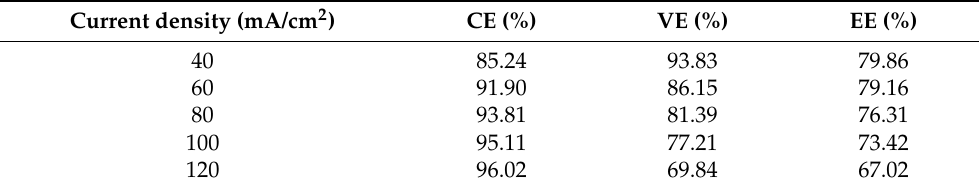
Figure 9. Efficiencies of the VRFB single cell with APPJ-coated polydopamine on GF at different current densities. Table 1. Efficiencies of the VRFB single cell with APPJ-coated polydopamine on GF at different current densities of 40, 60, 80, 100 and 120 mA/cm 2 .